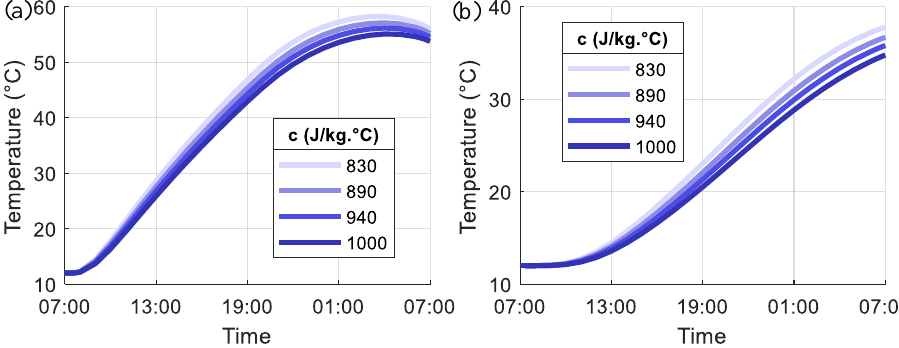
Figure 19. Temperature change in the first loading cycle for different c at: ( a ) the midpoint of the pile section; ( b ) the outer surface of the pile section.